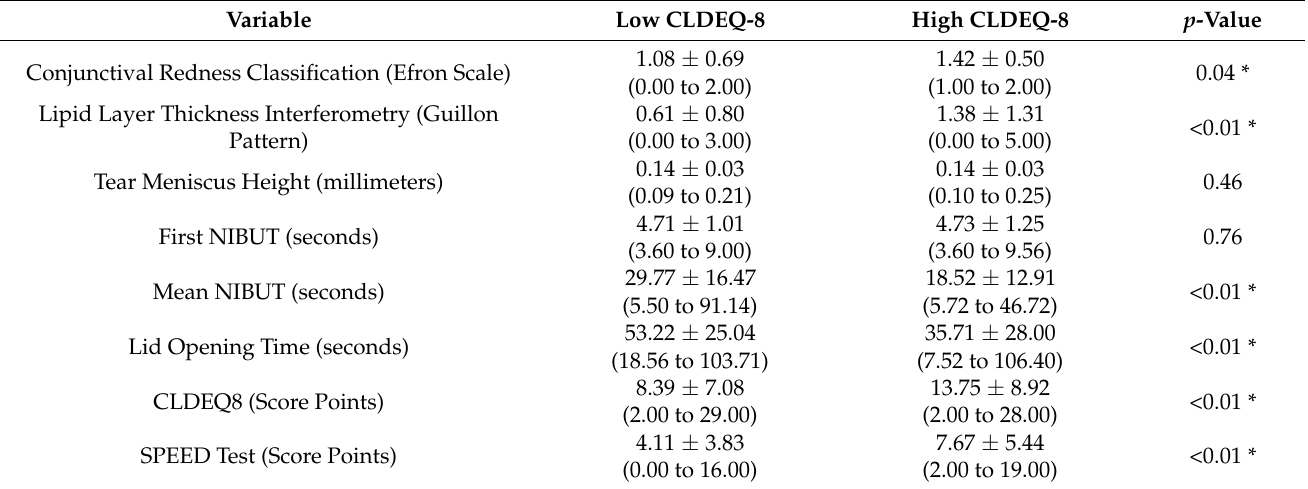
Table 2. One-month outcomes divided by CLDEQ-8